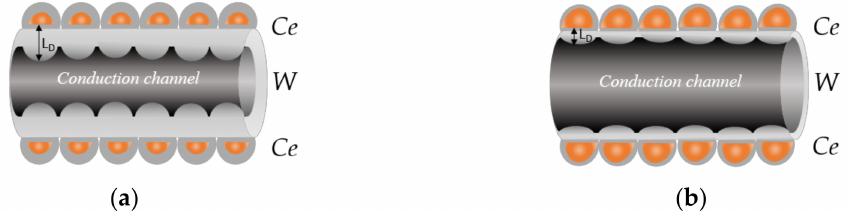
Figure 11. The schematic view of the heterojunction formed at the surface of the cerium oxide ( Ce ) core-shell tungsten oxide ( W ) wires and the possible mechanism (a) after exposure to air and (b) reducing gases such as acetone. L D is the Debye length or depth of the depletion region from the surface (not at